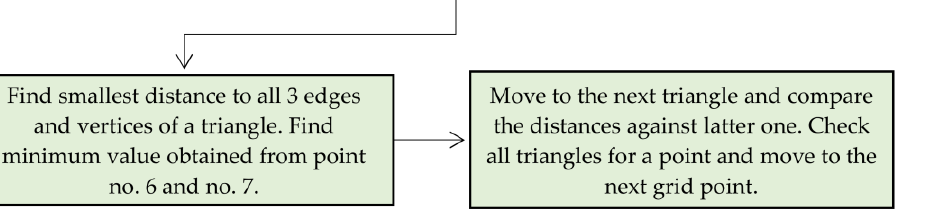
Figure 3. Finding the distance of a point.